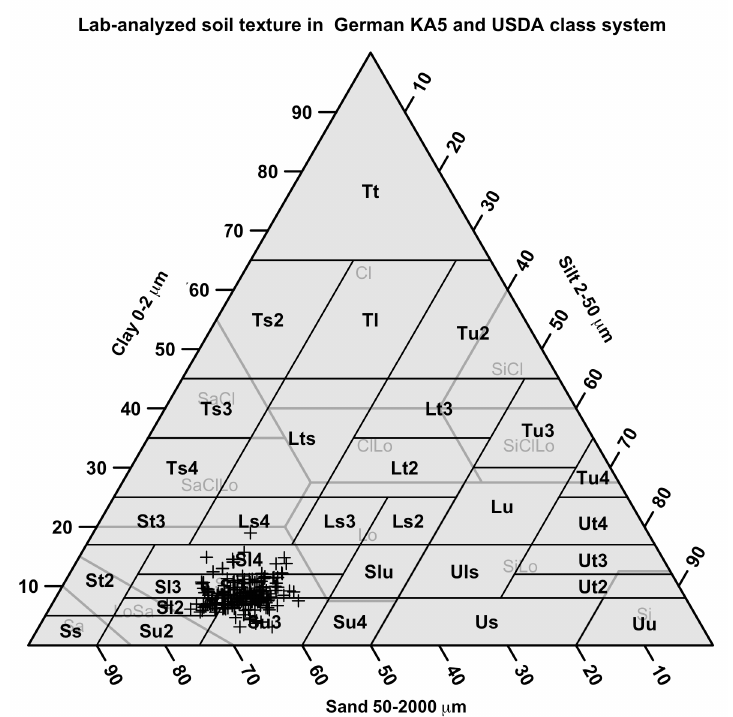
Figure 6. Lab-analyzed soil samples plotted on the German KA5 classification triangle and over plotted with the USDA